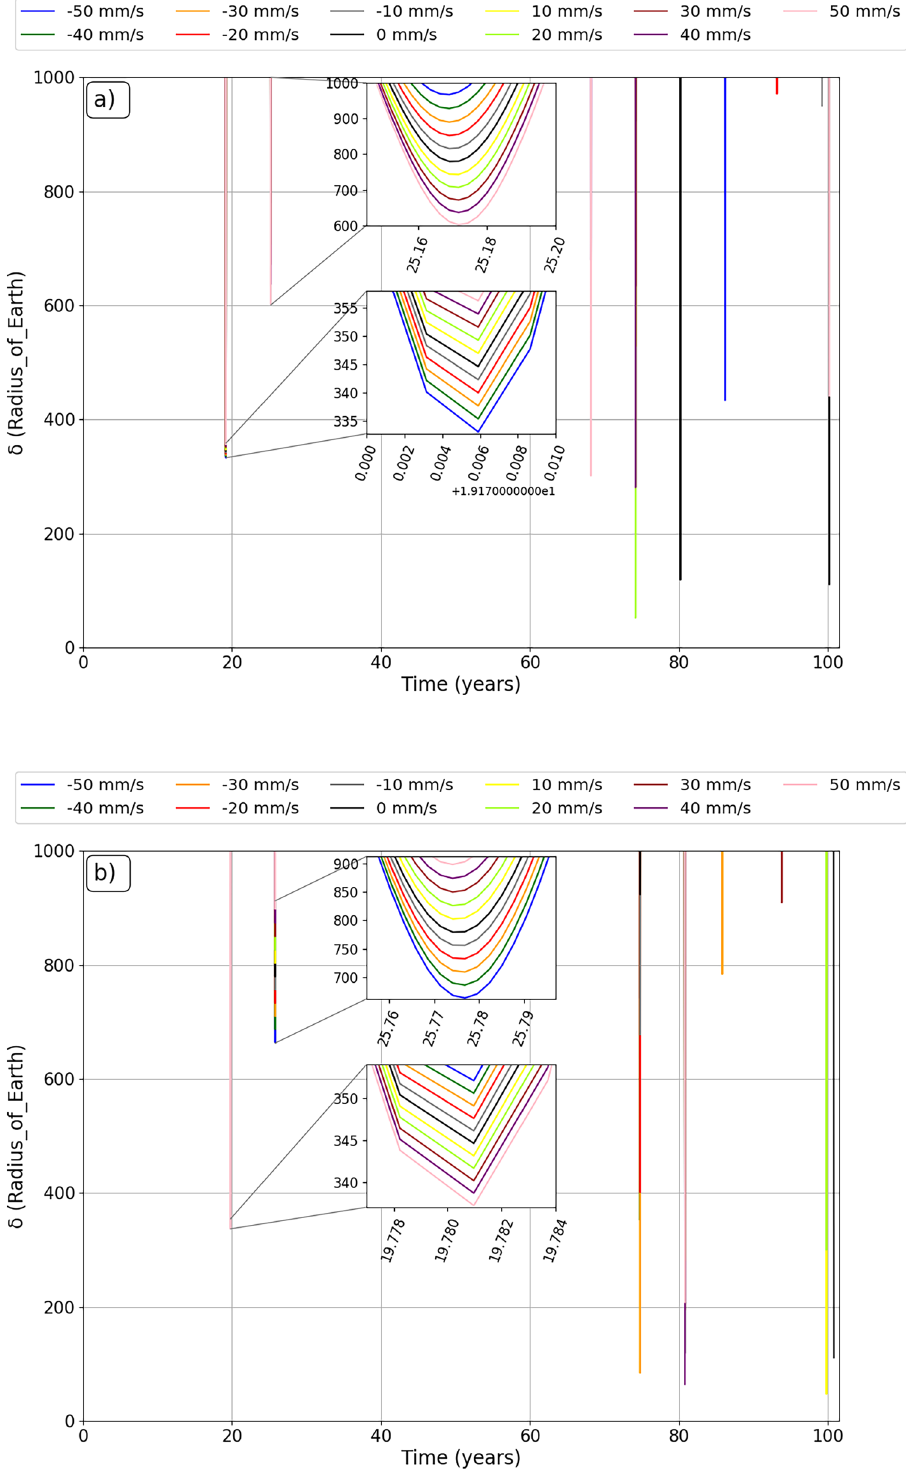
Figure 5. The relative distances between the asteroid and the Earth ( δ ) for an impulse applied at the perihelion on July 19, 1980 ( a ) and aphelion on December 11, 1979 ( b ). We zoomed in on the first two close encounters to better visualize the variations in the approach between the asteroid and